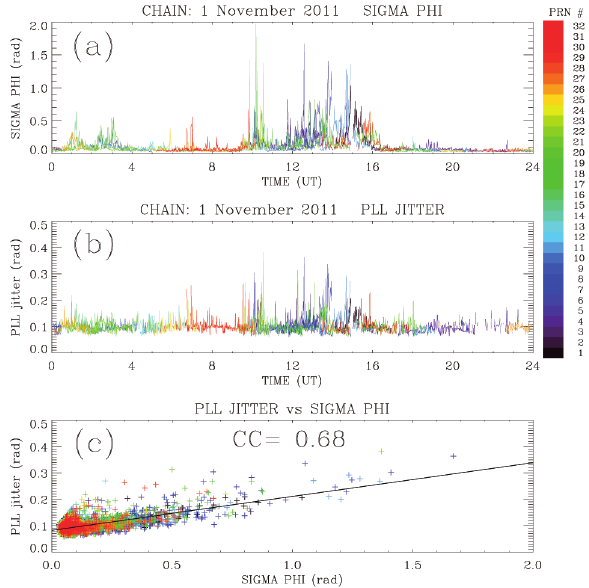
Figure 9. Phase scintillation index v U (a), receiver PLL jitter (b), and correlation between v U and the PLL jitter